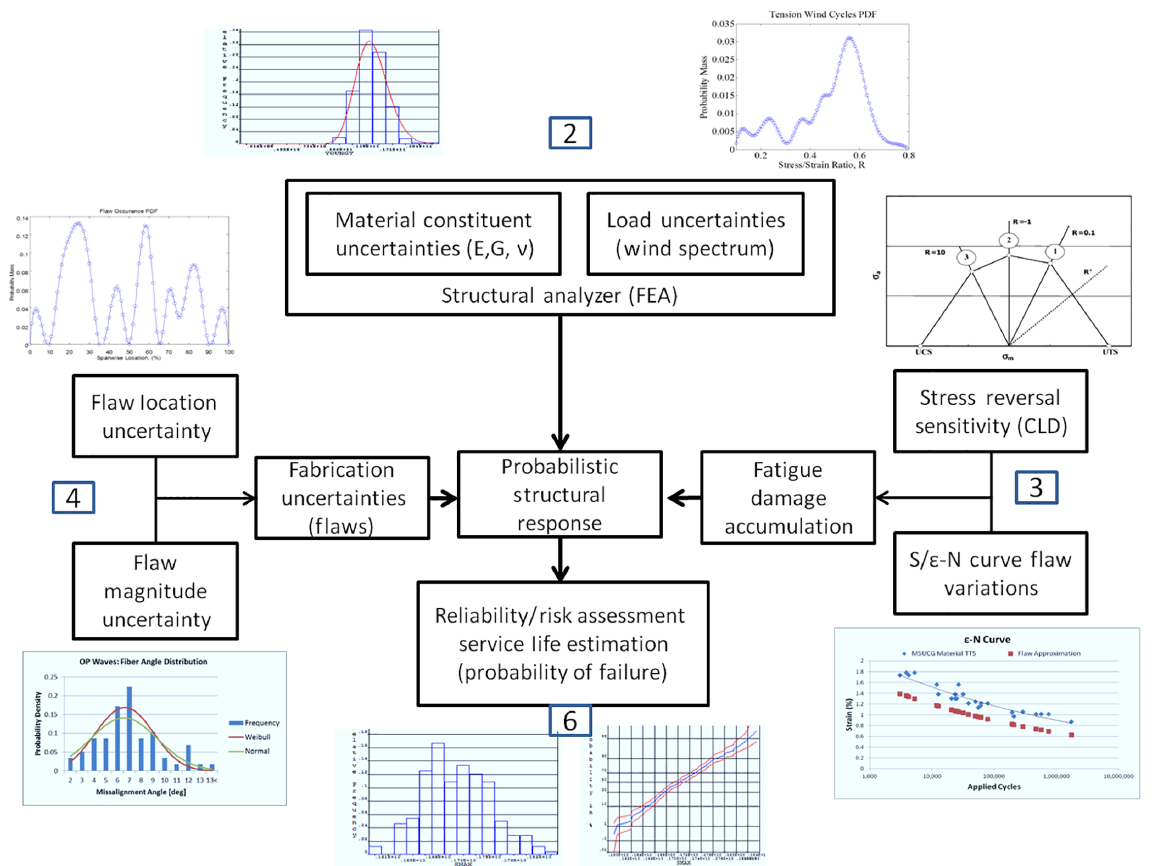
Figure 3. FEA and risk analysis overview with steps 2, 3, 4, and 6 corresponding to Table 1